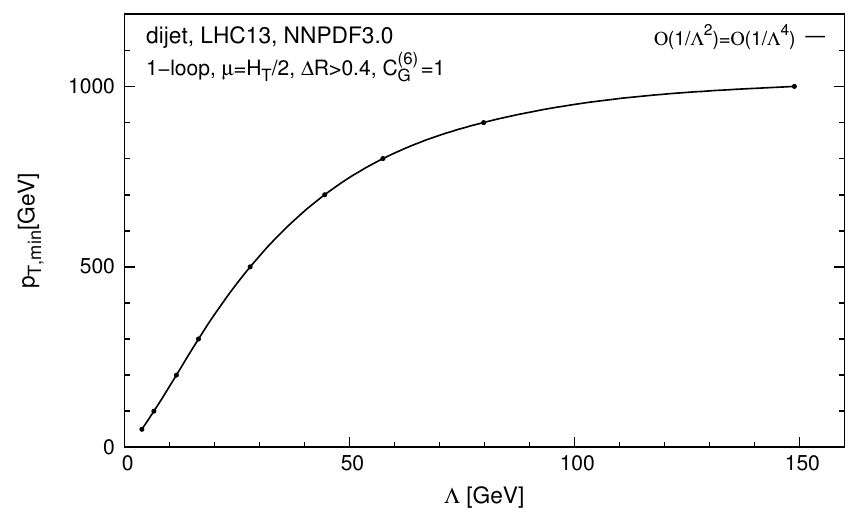
Figure 12 . Value of the partonic jet cut p T; min ( j ) at which the contribution of order O (1 = (cid:3) 4 ) exceeds the one of the one-loop interference term of order O (1 = (cid:3) 2